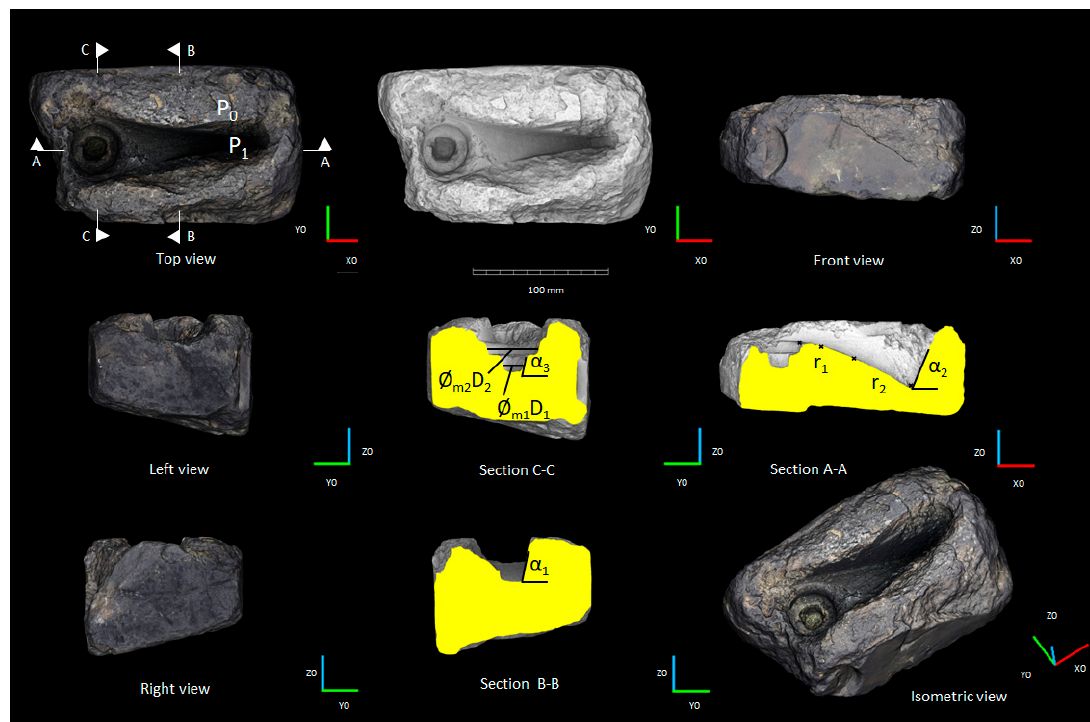
Figure 16. Example of orthoviews, isometric views and sections of the Sorradile (S1) 3D model. Dimensional indicators and orientation of worked surfaces and holes on 3D model. DP 0 − P 1 = mould depth; D n = mould depth; Ø = diameter of circular shapes; Ømn = average diameter of the circular shape.